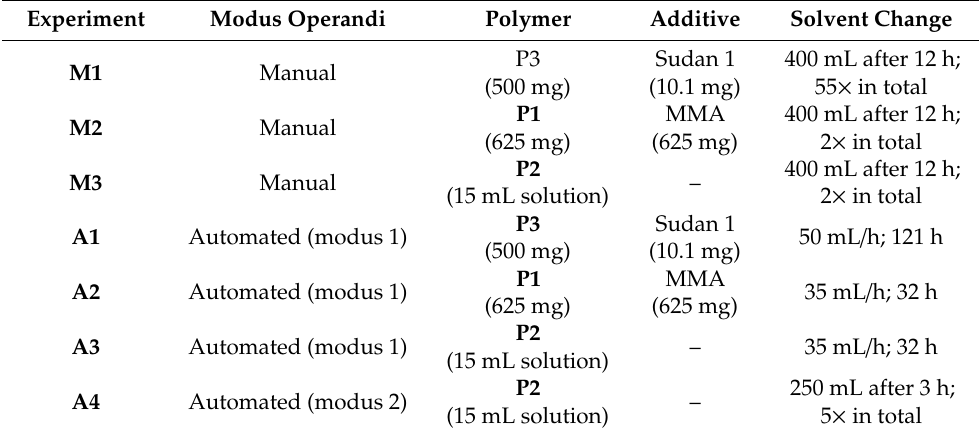
Table 3. Summary of the dialysis